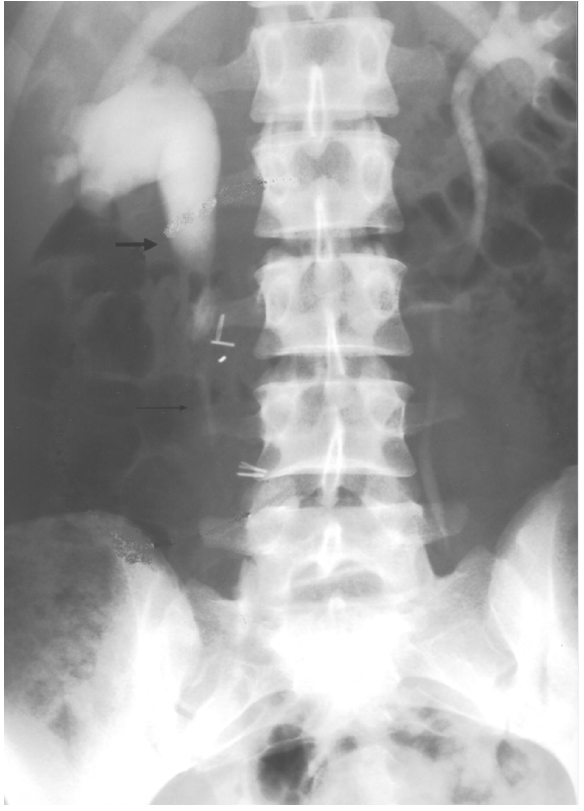
Figure 4 – Excretory urography performed after reconstruction showing good drainage of the ureter (thick arrow = pre-anasto- mosis; thin arrow =